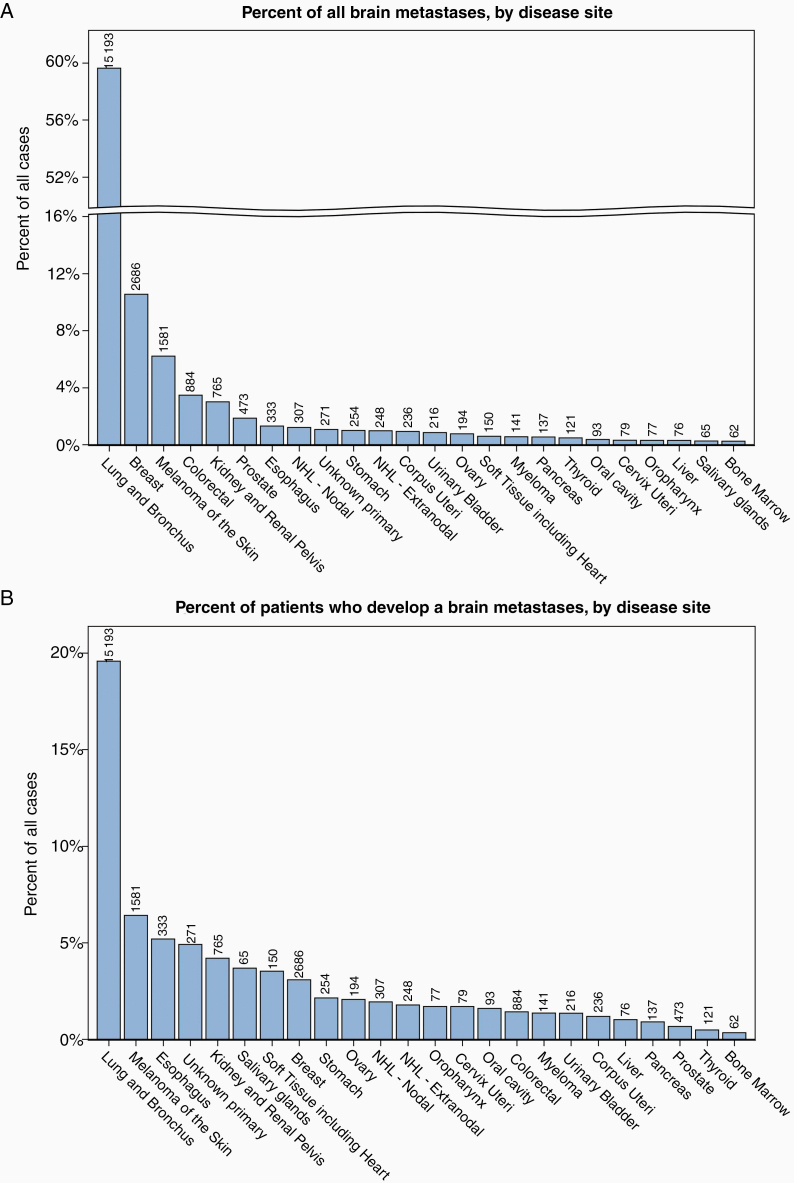
Intracranial metastatic disease by disease site. (A) Percent of all brain metastasis by disease site (minimum 50 metastases). (B) Probability of brain metastasis by disease site (minimum 50 metastases). (C) Time from primary diagnosis until metastasis (select disease sites). SEER, Surveillance, Epidemiology, and End Results.